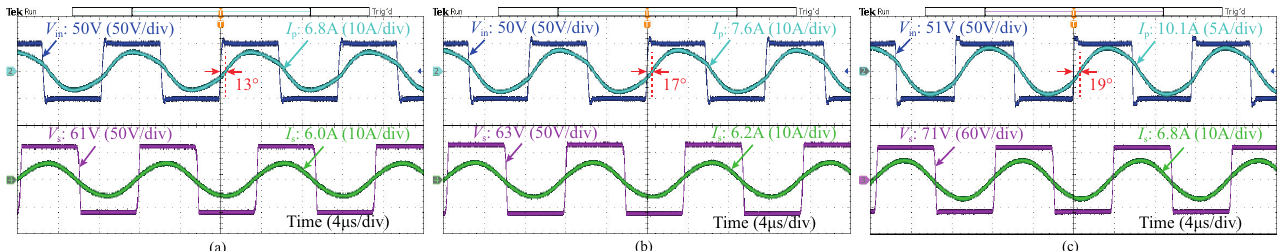
Figure 12. Steady-state experimental waveforms of V in , I p , V s , and I s with R B = 15 Ω under